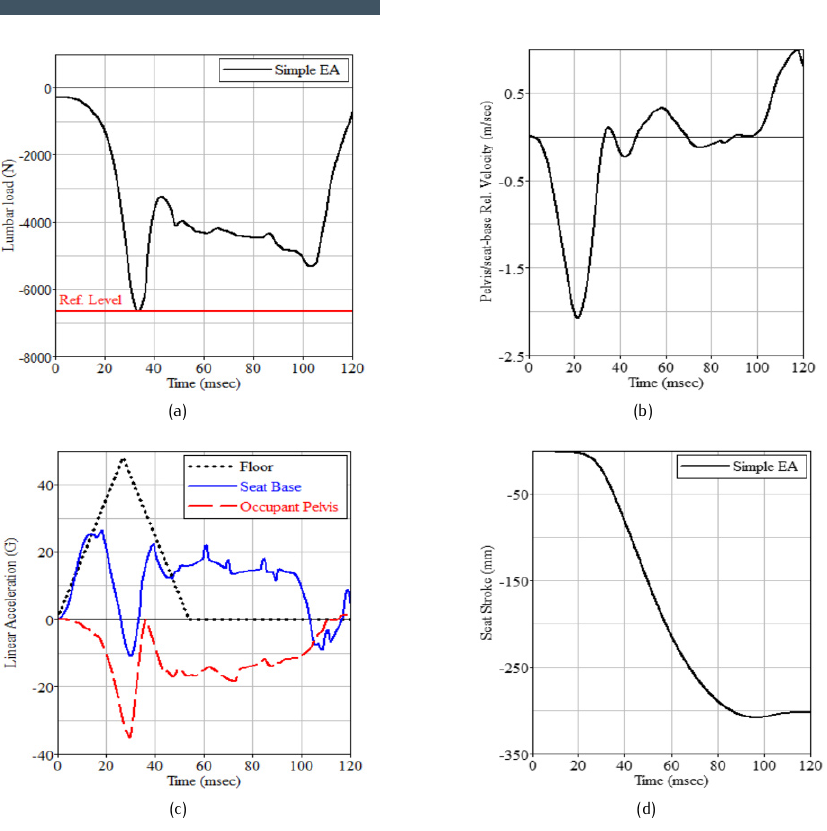
Figure 13. Occupant lumbar load, seat-base acceleration, seat/occupant relative velocity, and seat stroking curve for a simple load